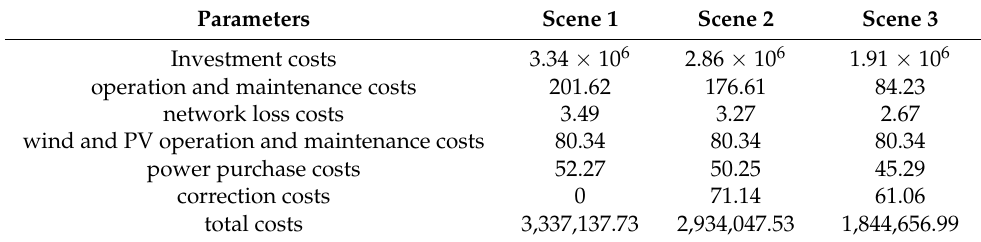
Table 4. The cost profiles of the configuration schemes (RMB).